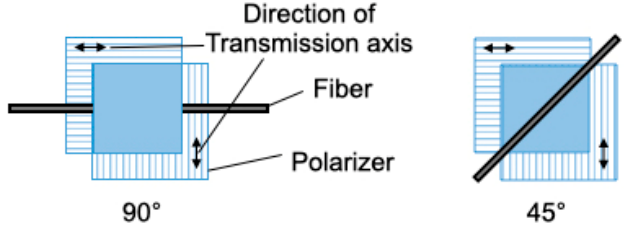
Figure 11. Examination of the molecular orientation of the fibers using crossed nicols. If the molecules were oriented, the image became dark at 90° and bright at 45°.